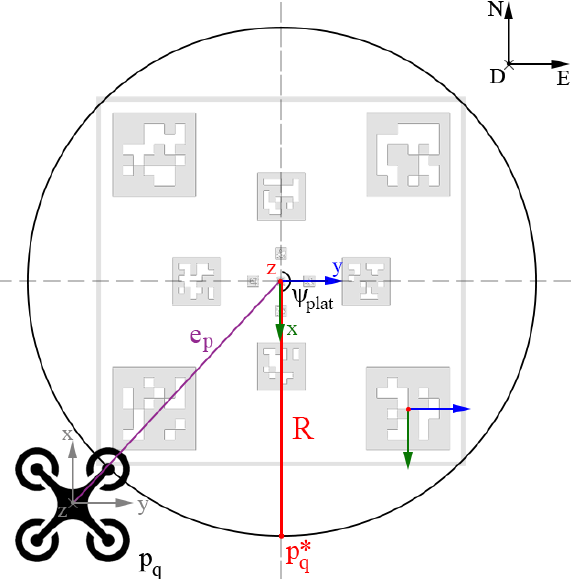
Figure 5. The generation of the initial relative position p ∗ q during the initialization phase. The quadrotor needs to place itself in front of the catamaran, and it does that by moving around the platform and placing at a certain distance from